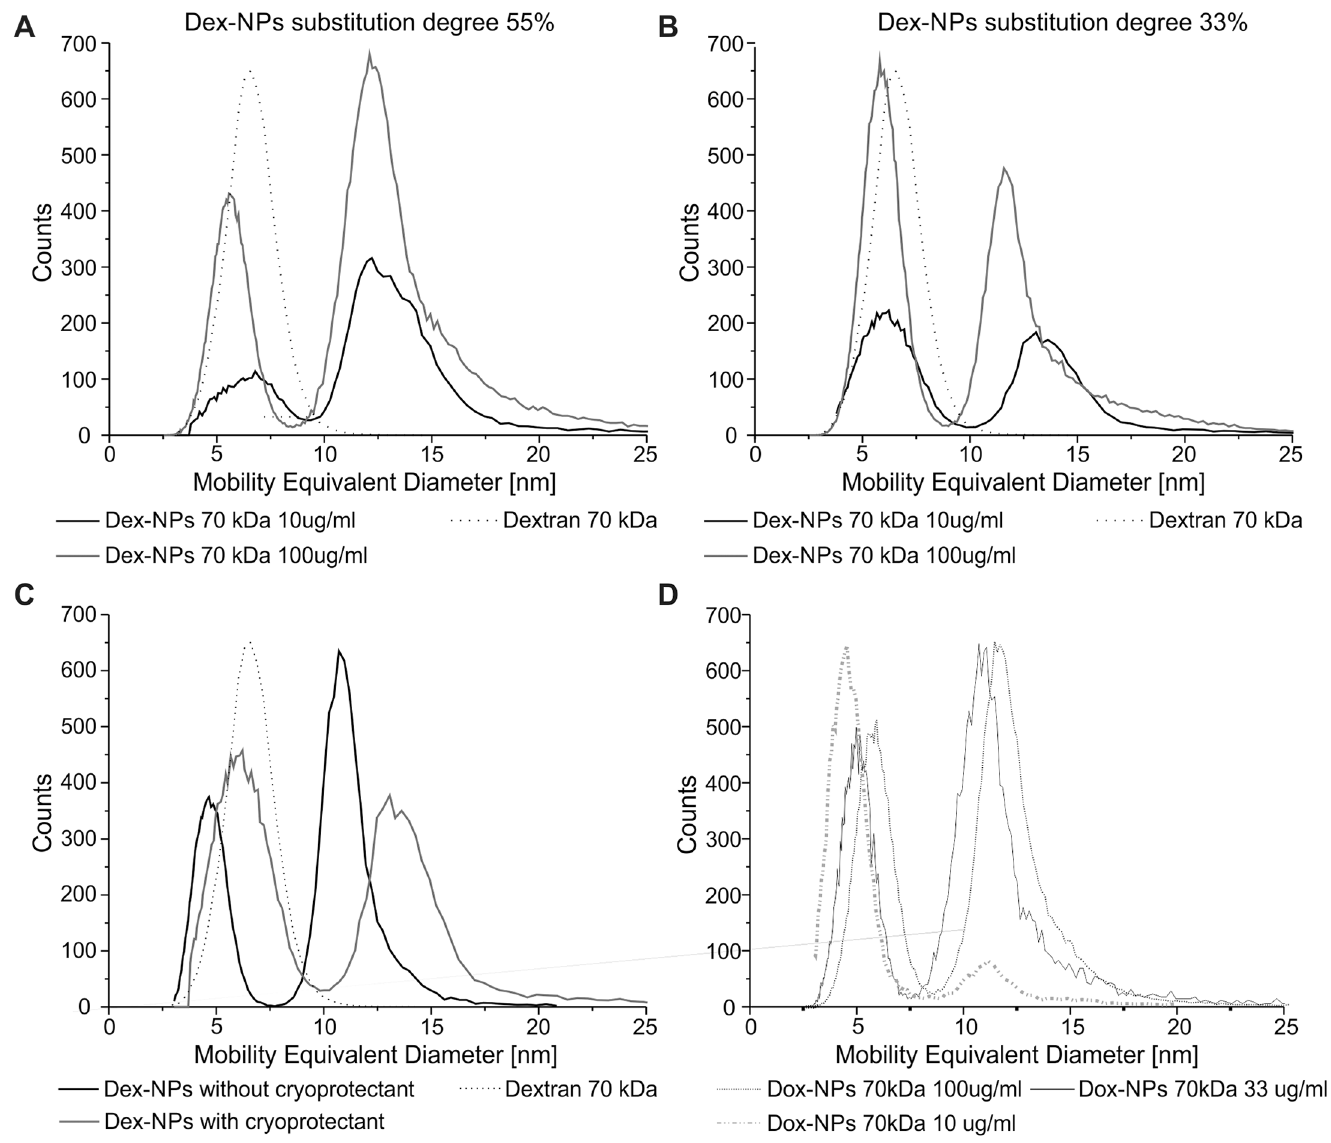
Fig 6. Mobility-equivalent diameter distribution of nanoparticles. Dex-NPs with a 55% (A) and 33% (B) degree of substitution (10 μ g/ml and 100 μ g/ml) referred to pure dextran 70 kDa (7 μ g/ml). (C) Dex-NPs with a 33% degree of substitution (10 μ g/ml) with and without cryoprotectant referred to pure dextran 70 kDa (7 μ g/ml). (D) Dox-NPs with a 33% degree of substitution (10 μ g/ml; 33 μ g/ml and 100 μ g/ml). Mean n =